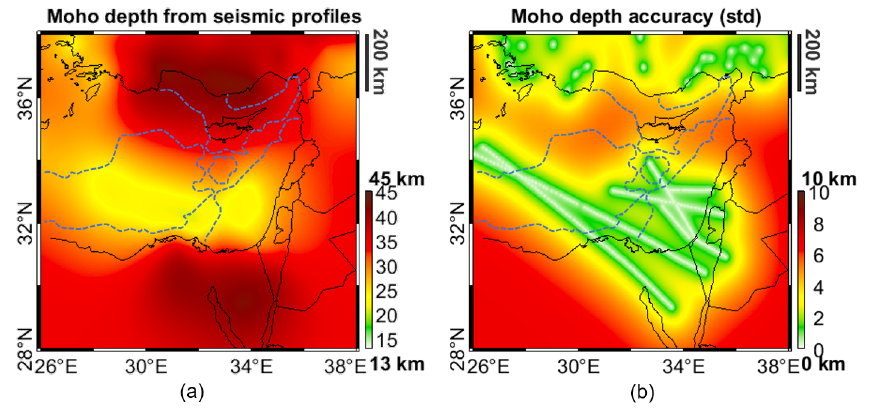
Figure 8. The Kriging interpolation of the seismic data ( a ) and its corresponding estimation error STD ( b ). Dashed blue lines represent the boundary of the main geological provinces.